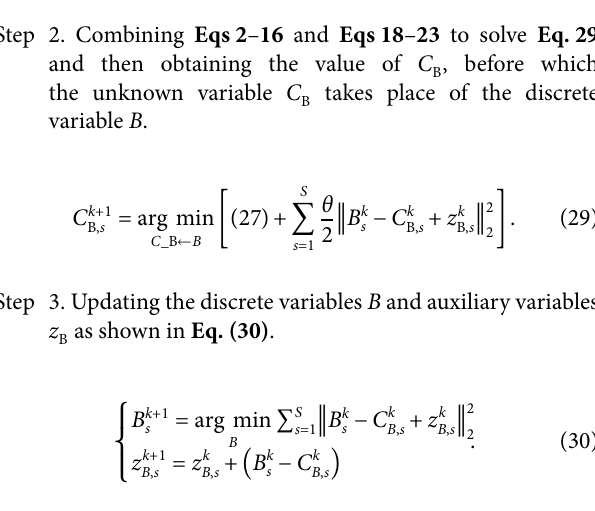
Frontiers in Energy Research |